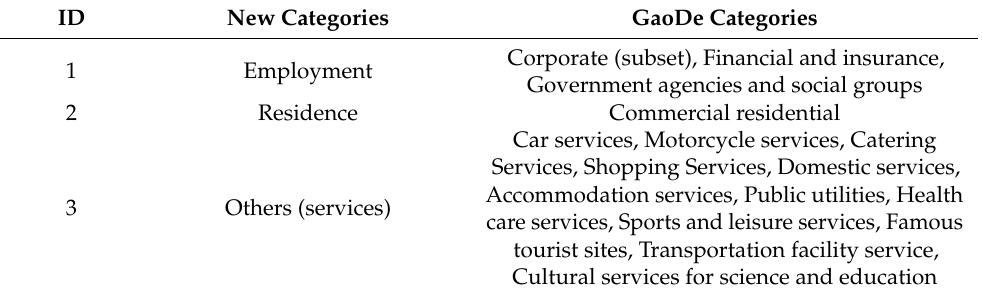
Table 3. Categories of POIs.